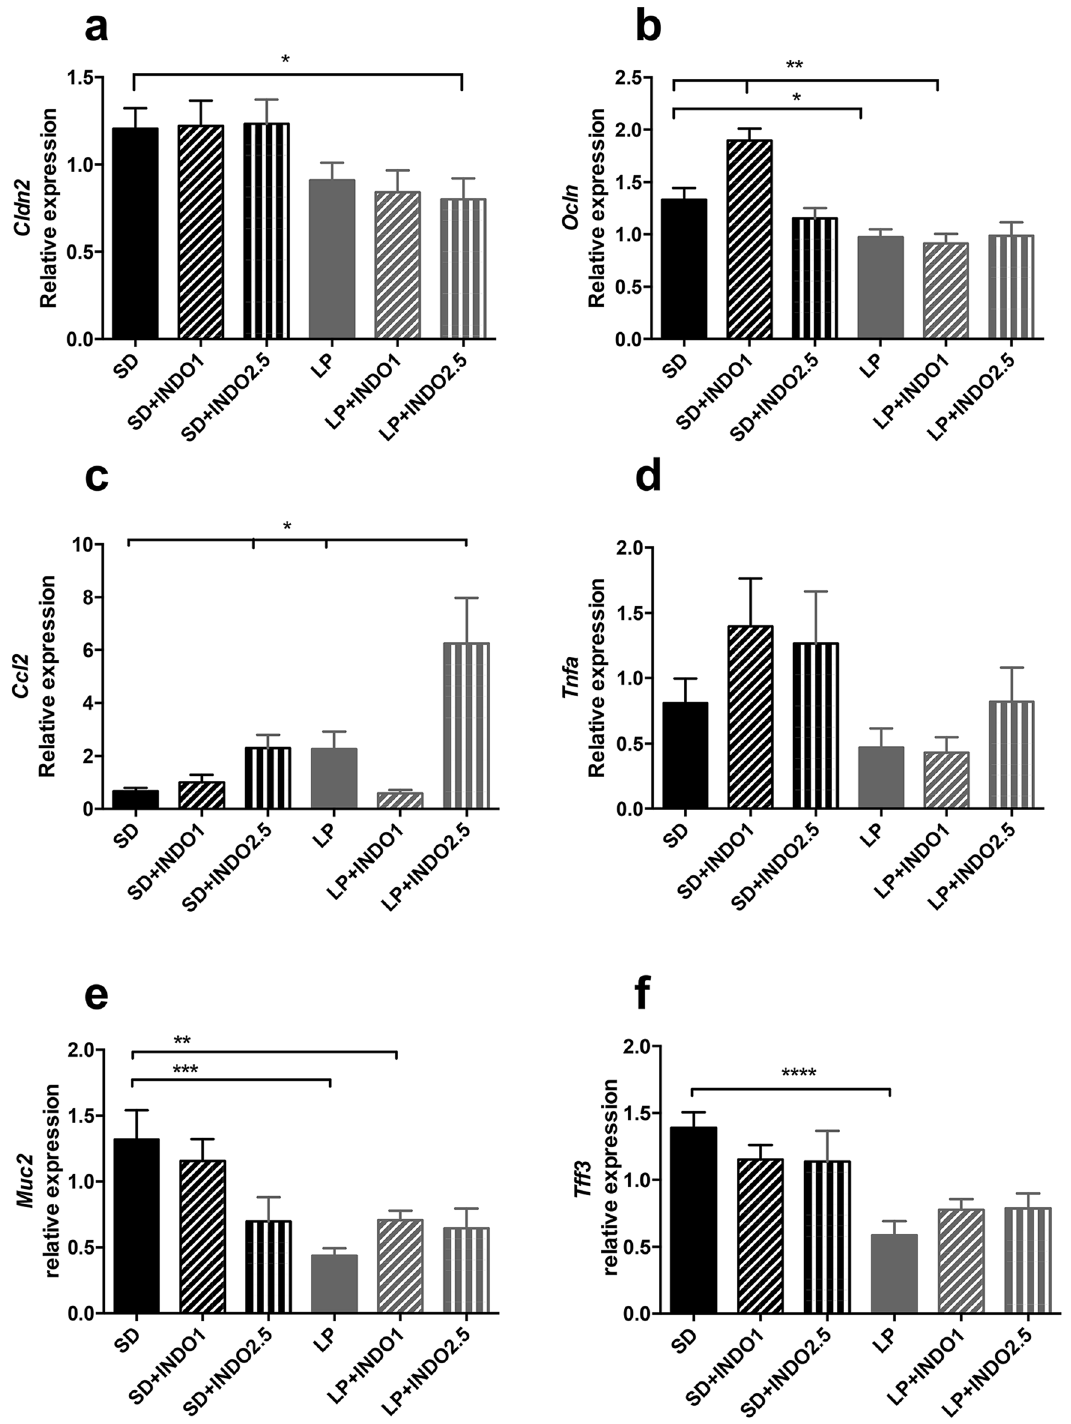
Figure 5. Cytokine and tight junction proteins RNA expression assessment in C57BL/6 mice fed a low protein or isocaloric standard diet combined with chronic indomethacin gavages Jejunal tight junction protein mRNA relative expression as ( a ) Cldn2 (t-test *p = 0.0336); ( b ) Ocln (t-test **p < 0.01; *p = 0.0171) were measured. Proinflammatory cytokines mRNA levels in the jejunum as ( c ) Ccl2 (t-test *p < 0.05) and ( d ) Tnfa were measured. Protective components of gut barrier ( e ) Muc2 (t-test **p < 0.0132, ***p < 0.0013) and ( f ) Tff3 (Mann– Whitney test ****p < 0.0005) mRNA relative expression were performed. Bars indicate the mean ± SEM Unpaired t-test or Mann–Whitney test was performed. SD, Standard diet; SD INDO 1 Standard Diet + indomethacin gavages (1 mg/kg); SD INDO 2.5 Standard Diet + indomethacin gavages (2.5 mg/kg); LP, Low protein diet; LP INDO 1 LP + indomethacin gavages (1 mg/kg); LP INDO 2.5 LP + indomethacin gavages (2.5